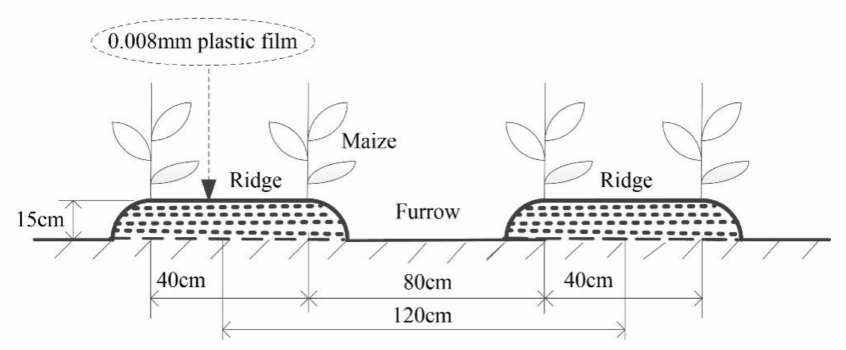
Figure 8. Schematic diagram of large-ridge-double-lines planting